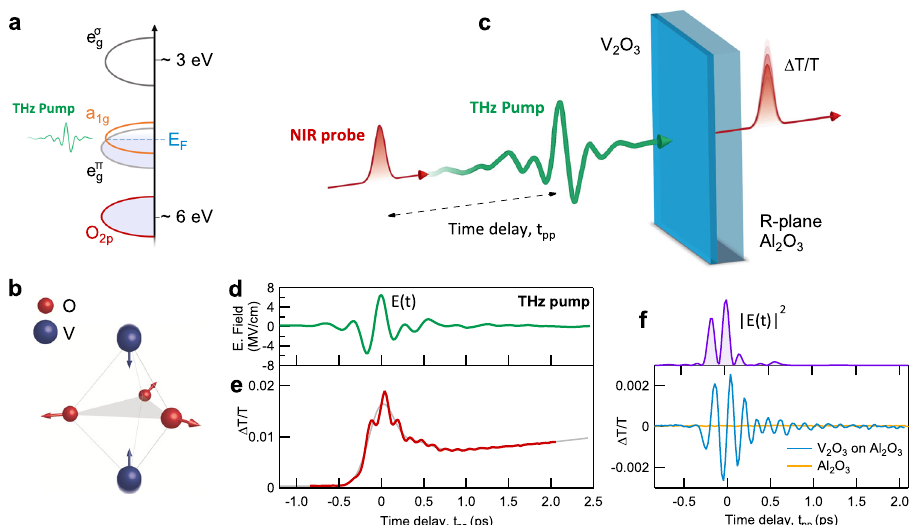
Fig. 1 Coherent phonon generation by terahertz electronic excitations in V 2 O 3 . a Energy level diagram for the paramagnetic metallic phase of V 2 O 3 showing vanadium and oxygen energy levels. The Fermi energy E F crosses the partially fi lled a 1 g and e π bands formed by vanadium 3 d orbitals. O 2 p bands lie g between 3.5 and 8.5 eV below E F while e σ is centered at ~ 3 eV above E F . Level diagrams adapted from ref. 32 . b Phonon displacement vectors of the A 1 g g phonon mode in V 2 O 3 . c Schematic of the setup for the THz pump-NIR probe experiment on V 2 O 3 thin fi lm on R-plane Al 2 O 3 substrate to investigate the THz driven coherent lattice dynamics: intense THz pulse (green) excites the A 1 g phonon mode, whose coherent dynamics are probed by a temporally delayed ultrashort optical pulse (red). d Waveform of THz pump electric fi eld. The peak electric fi eld is 6.5 MV/cm. e Probe transmission modulation signal Δ T / T as a function of the pump-probe delay t pp . The THz pump pulse induces coherent lattice oscillations related to the fully-symmetric A 1 g phonon at approximately twice the frequency of the driving electric fi eld. The red curve represents the experimental data. Gray curve represents the slowly-varying background as determined by double-exponential relaxation fi tting procedure (see Supplementary Note 4). f Light-blue curve shows the oscillatory component of Δ T / T time-trace of V 2 O 3 on R-plane Al 2 O 3 after subtracting the background. Orange curve is the Δ T / T dynamics of the bare R-plane Al 2 O 3 substrate measured in the same experimental conditions. The purple curve shows the intensity pro fi le ∣ E ( t ) ∣ 2 of the THz pump. Sample is at 300